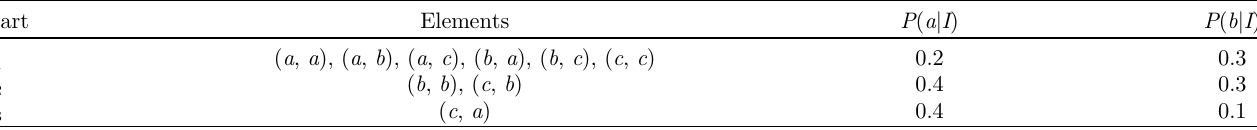
Table 1. Partition I and transition probability to each element in the alphabet A .